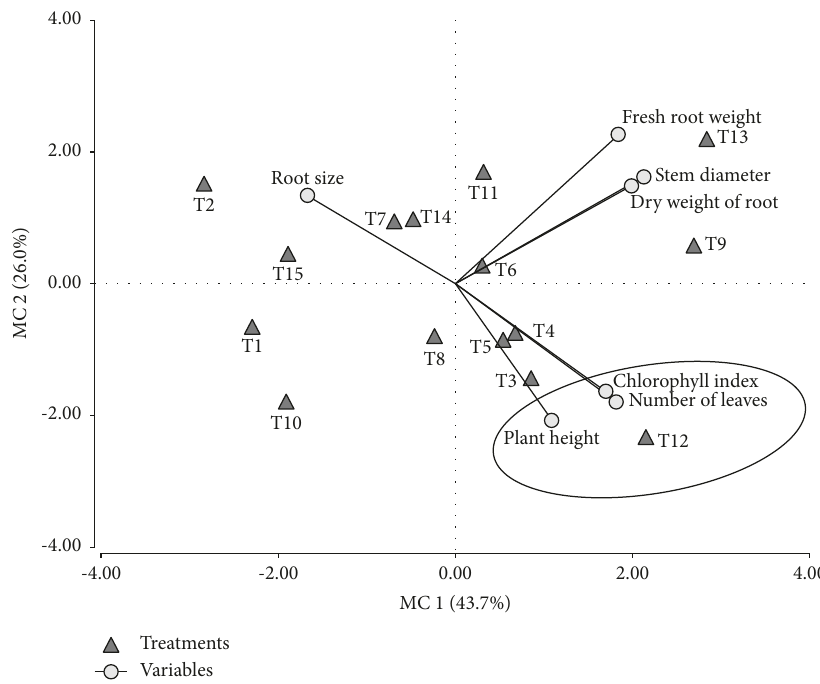
Figure 2: Principal component analysis for cocoa agronomic